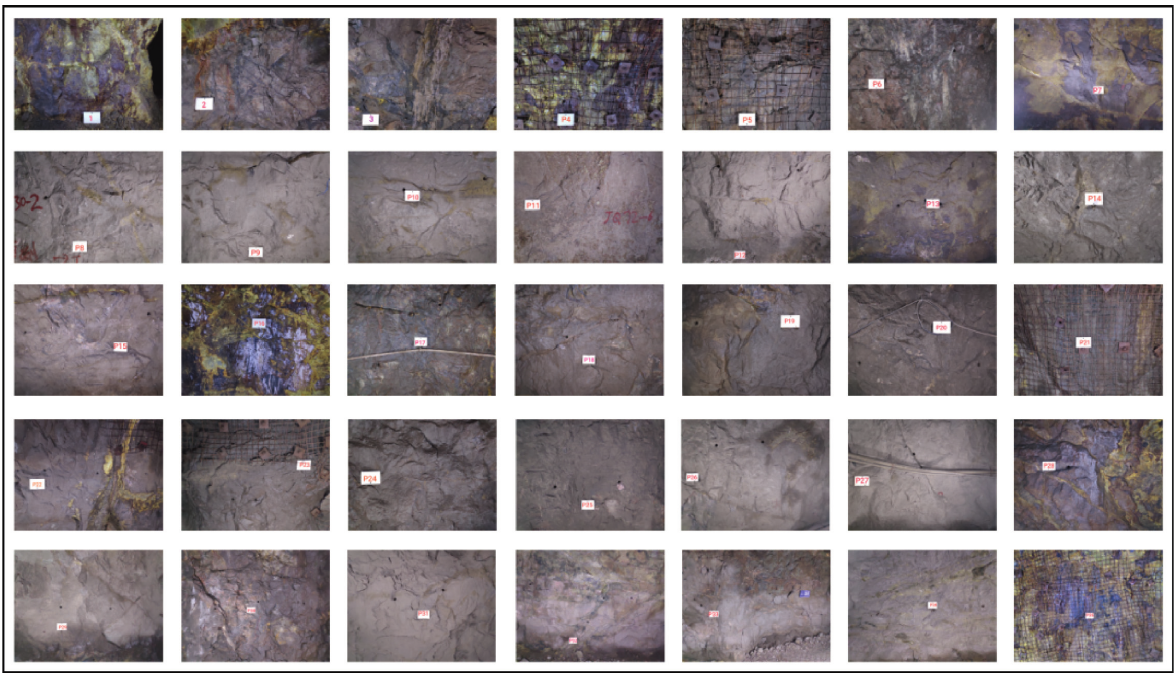
Figure 3: Close shot photography of joints and